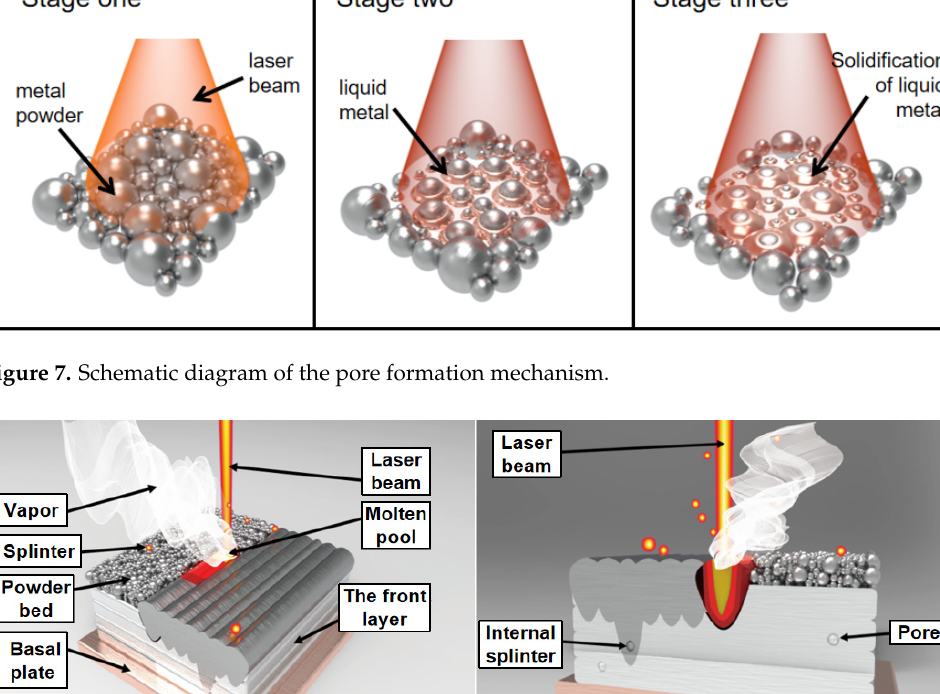
Figure 8. Defects in the SLM process.